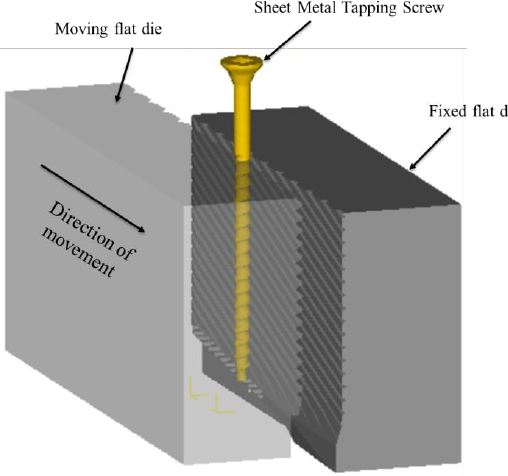
Figure 3. Flat-die thread rolling (with fixed flat die and moving flat die).